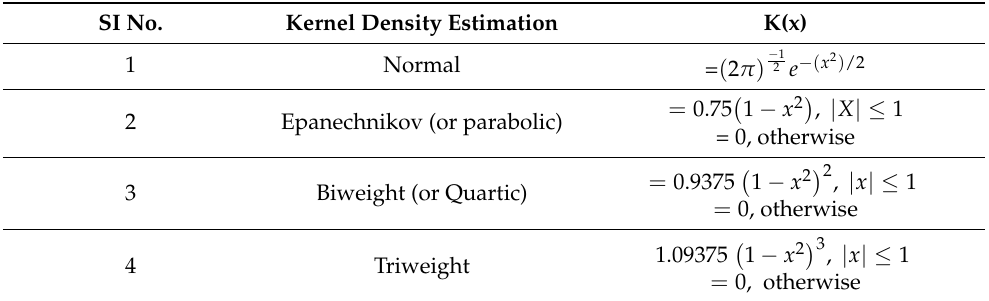
Table 1. 1-D Kernel density estimation (KDE) tested in the modelling of flood marginals. SI